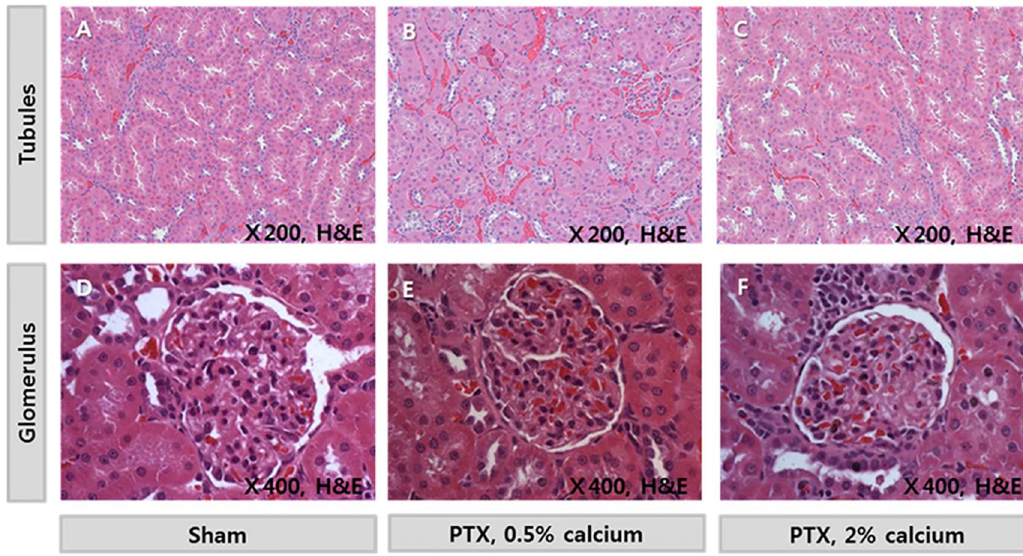
Fig 5. Histology of kidney glomeruli and tubules. Glomeruli and tubules exhibitednormal shapes and sizes. There were no signs of tubular atrophy, interstitial fibrosis, or interstitial inflammation. Calcium deposits were not observed on microscopic examination. Tissue sections were stained with hematoxylin and